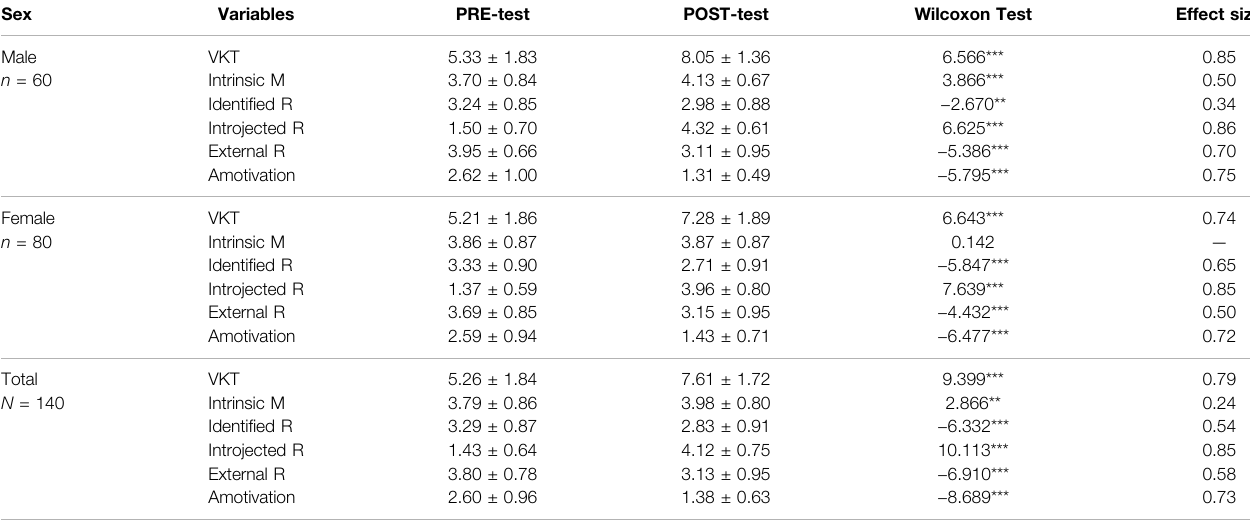
TABLE 5 | Comparing variables intra-group (pre vs post) using Wilcoxon test according to sex in fl ip group (Av ± SD).